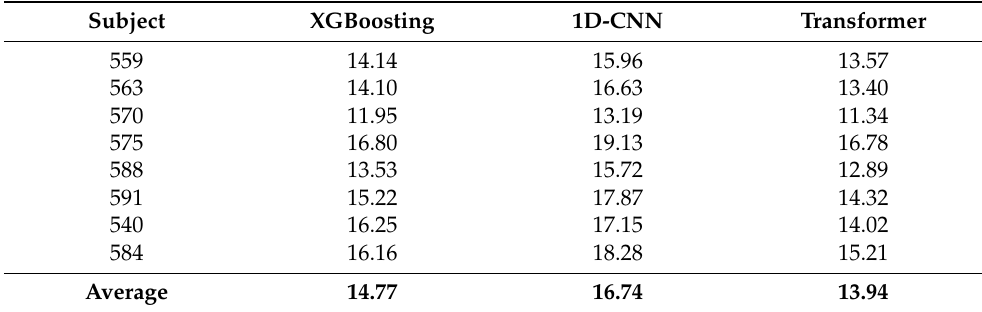
Table 3. RMSE for prediction models using only CGM as predictor without carrying out imputation.